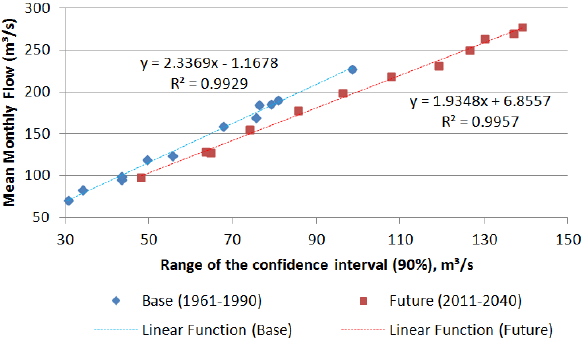
Figure 13. Variation of the value of C3( t ), based on the value of C3( t − 1), in modeling the time dependence component using ANN, keeping the other variables, C3( t − 2) and C3( t − 3), equal to 1 for the periods between 1961 and 1990 (base) and between 2011 and 2040 (future).